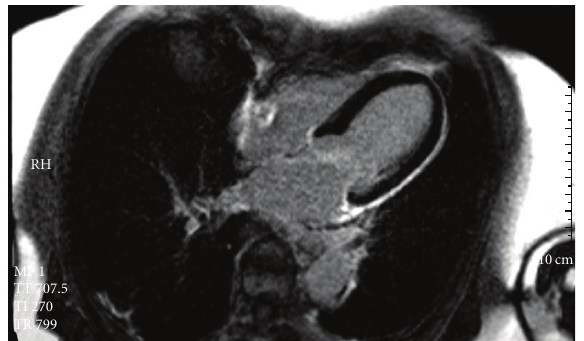
Figure 5: Cardiac magnetic resonance imaging showed a hyper- enhancement confined to the lateral